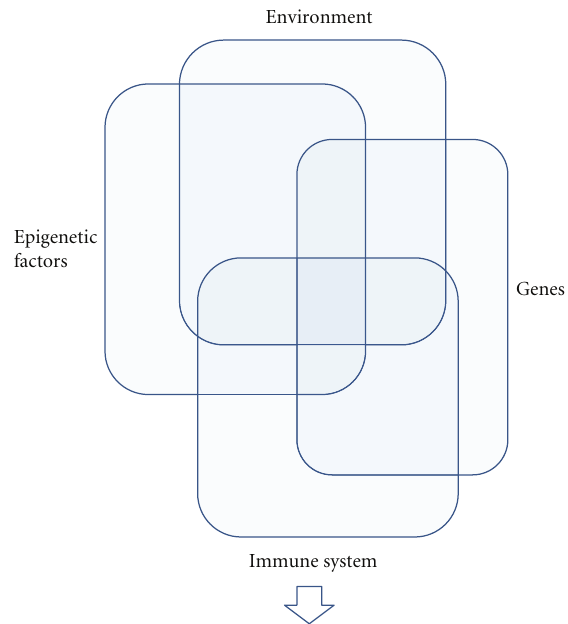
Figure 1: Understanding the pathogenesis of the disease also stems from studies of familial primary biliary cirrhosis (PBC). Clues as to the pathogenesis of the disease are provided by population studies involving a large number of families of a ff ected individuals and case reports (see also Table 1). These studies support the notion that the pathogenesis of the disease is complex, and that genes, epigenetic factors, and environment are mostly likely involved in concert rather than in isolation. The relative contribution of each of those factors is largely unknown and may vary among individuals and clusters. Their participation may be important for the induction of the immunopathological processes leading to PBC development, but may also be important for the progression of the disease towards a favourable slow pace or an unwanted progressive deterioration.